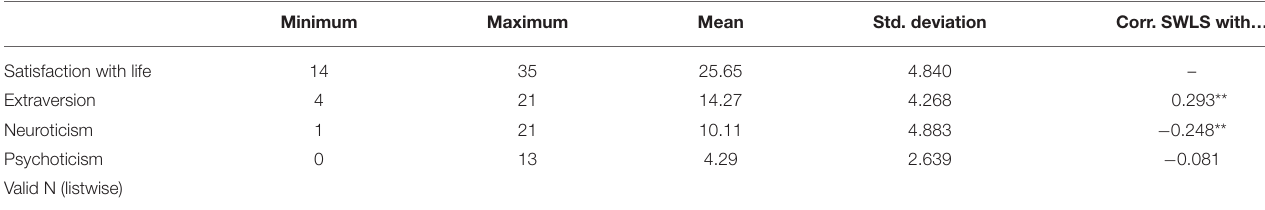
TABLE 1 | Means, standard deviations, and correlation between variables. Minimum Maximum